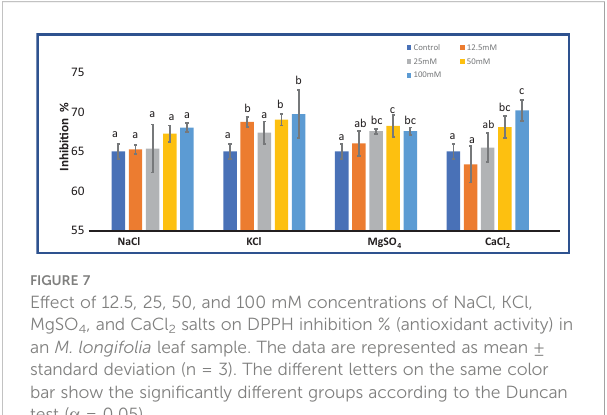
FIGURE 7 Effect of 12.5, 25, 50, and 100 mM concentrations of NaCl, KCl, MgSO 4 , and CaCl 2 salts on DPPH inhibition % (antioxidant activity) in an M. longifolia leaf sample. The data are represented as mean ± standard deviation (n = 3). The different letters on the same color bar show the signi fi cantly different groups according to the Duncan test ( a = 0.05).